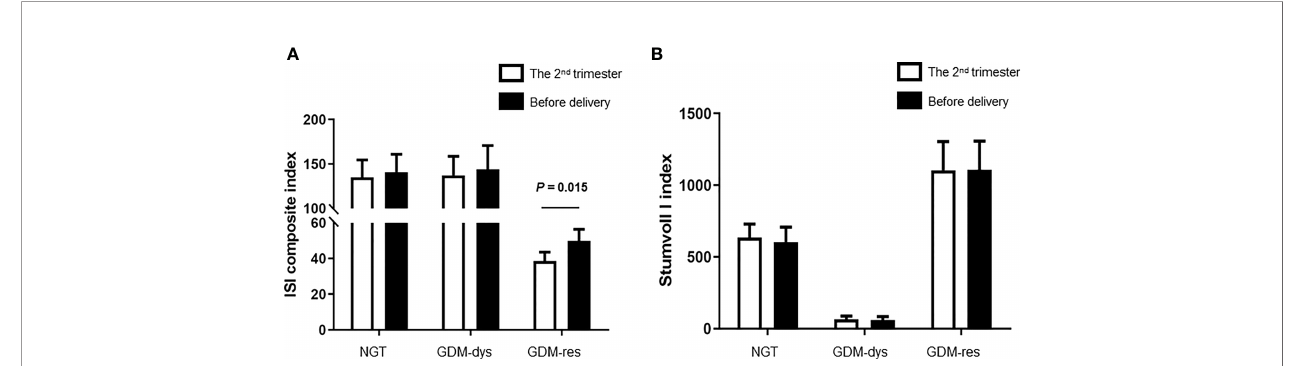
FIGURE 1 | Comparison of ISI Composite and Stumvoll I Indexes between the 2 nd trimester and before delivery. (A) ISI Composite Index. (B) Stumvoll I Index. Data were analyzed by Mann-Whitney U test. NGT, n = 13; GDM-res, n = 17; GDM-dys, n = 9.